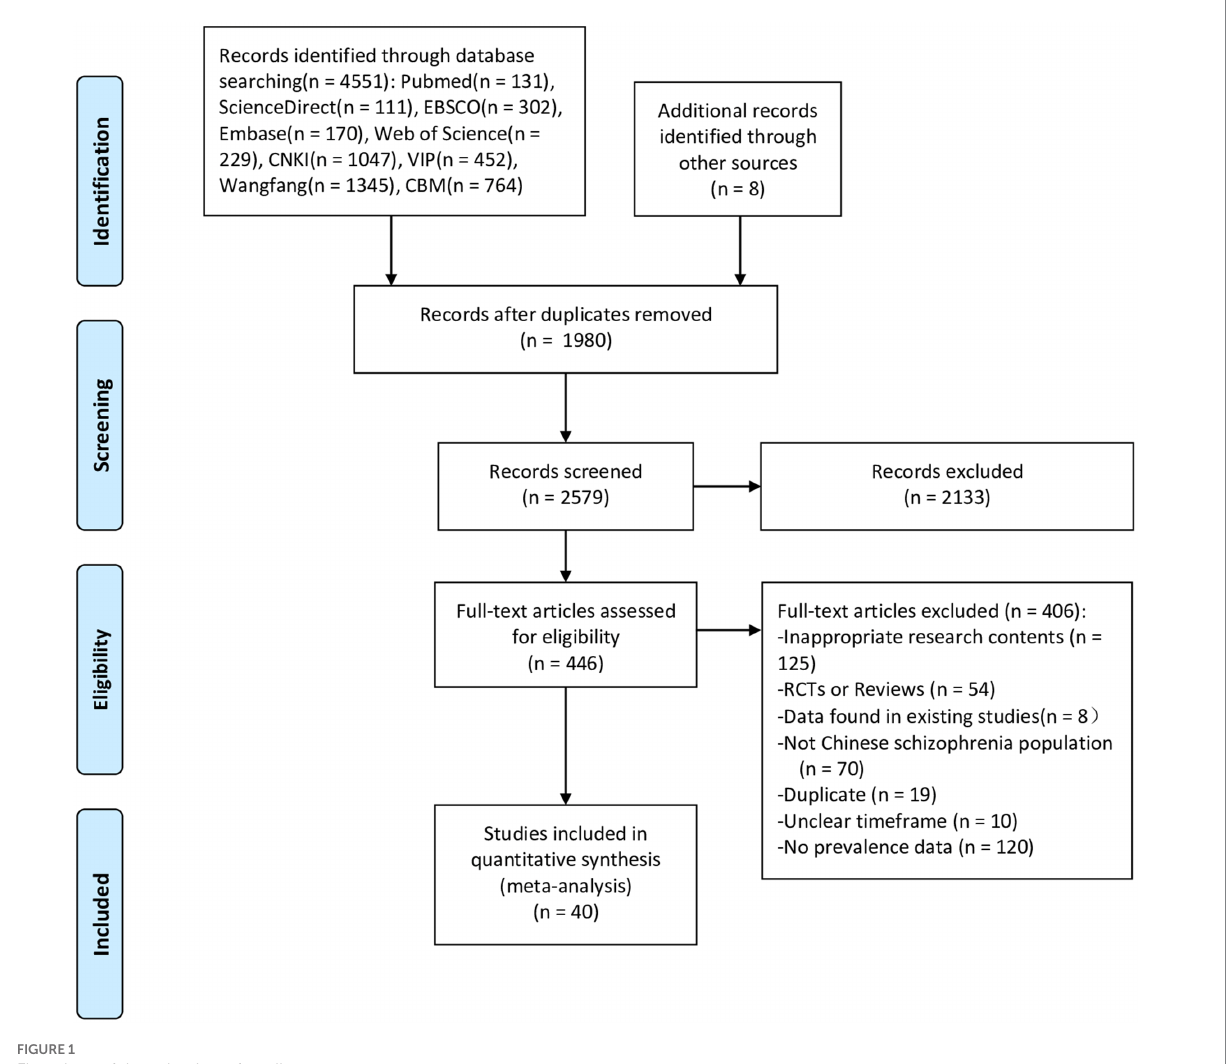
FIGURE 1 Flowchart of the selection of